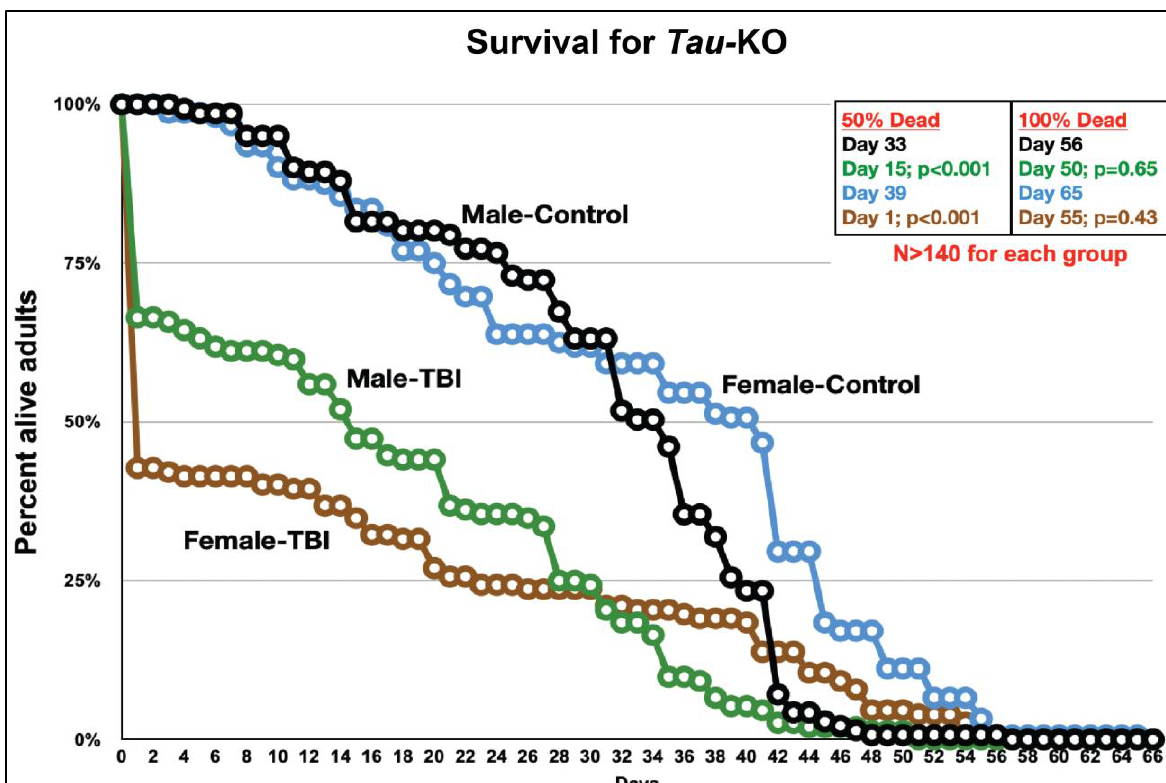
Figure 2. Tau- KO does not affect survival time in Drosophila. Survival curve of tau -KO flies at control and after TBI. Adult male and female 10 – 14-day old control and TBI flies were housed in separate vials. Flies were transferred into new vials every 2 – 3 days and the number of dead flies were counted every day till all flies died. Fifty percent death was observed in both sexes after TBI but Tau ablation did not affect the overall lifespan of TBI inflicted flies. Kaplan – Meier (Log-rank) test was used to compute statistical significance between control and TBI conditions ( p < 0.05). The p -values indicated compare the differences between male-control to male-TBI (black to green) and female-control to female-TBI (blue to brown) flies at 50% and 100% death in the population.